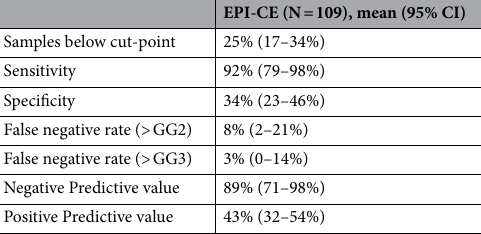
Table 2. Performance characteristics of EPI-CE at the 15.6